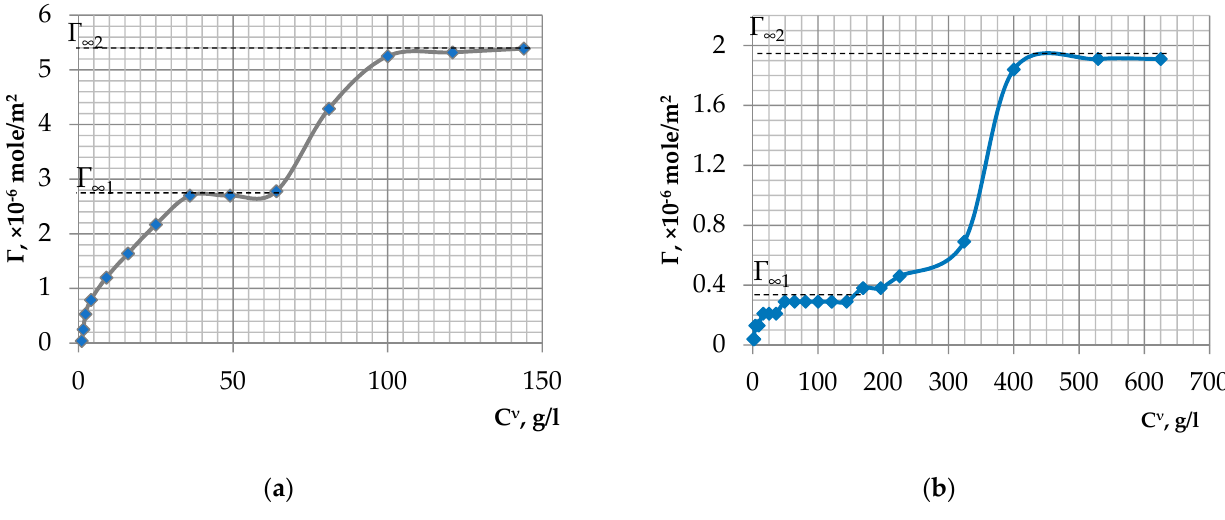
Figure 16. Surface tension isotherms of the plasticizer in σ -C ν coordinates: ( a )—in soft water No. 1,